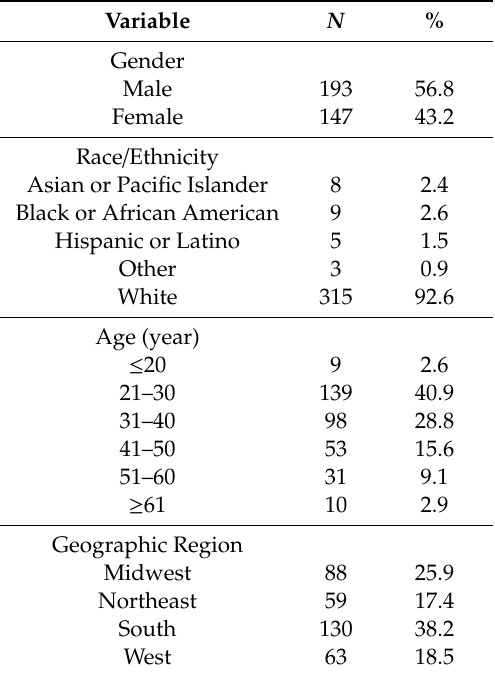
Table 1. Demographics Characteristics of